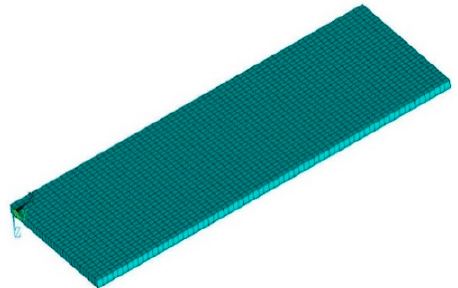
Figure 17. F inite element (FE) model of experimental laboratory floor. Figure 17. Finite element (FE) model of experimental laboratory